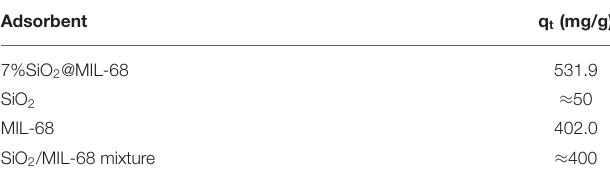
TABLE 3 | Aniline adsorption